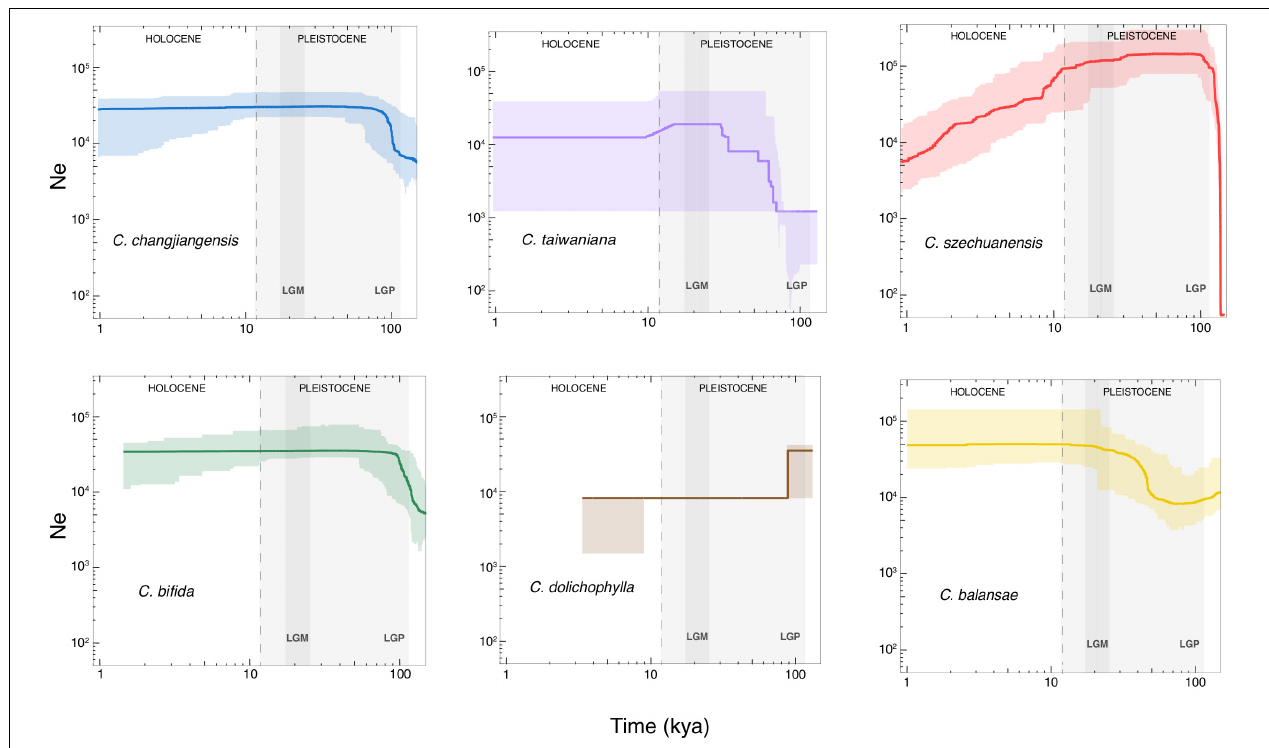
FIGURE 5 | Demographic history inferred by Stairway Plot for the six studied species of Cycas . The x axis indicates time before present in thousand years ago (kya) on a log scale, and the y axis represents the effective population size. The bold color curve and the light color shaded areas show the median estimate and 95% confidence interval, respectively, based on 200 bootstrapped sequences for each species. The light and dark gray shaded areas indicate the last glacial period (LGP) and the Last Glacial Maximum (LGM), respectively.